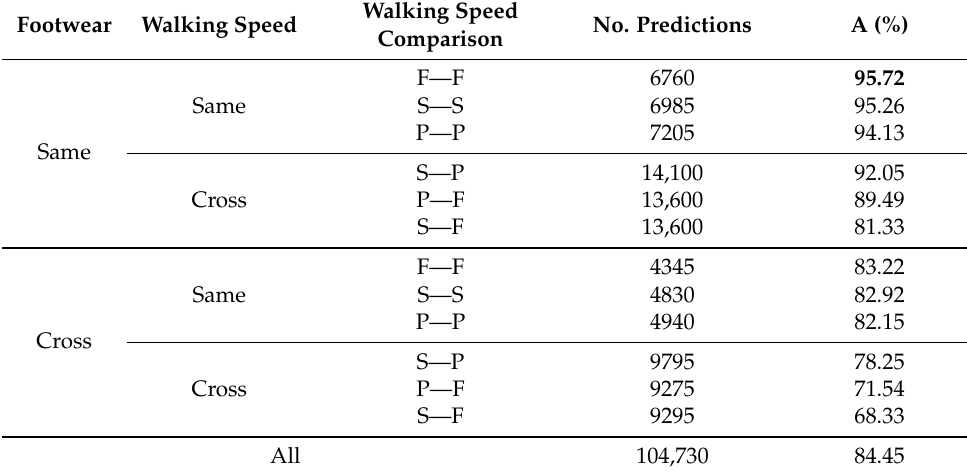
Table 4. Accuracy (A) across all test sets within D AS , AF for specific between-session speed and footwear comparisons. The highest A is in